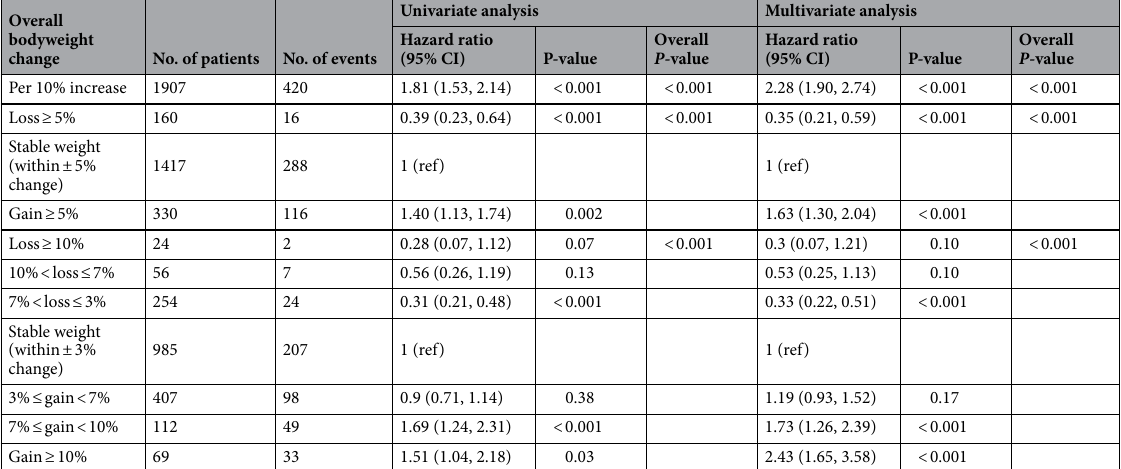
Table 3. The risk of NAFLD according to overall bodyweight change. Adjusted for age, sex, hypertension, diabetes, waist circumference, body mass index, triglyceride, high density cholesterol, total cholesterol, alanine transaminase, and number of measurements. NAFLD nonalcoholic fatty liver disease, CI confidence